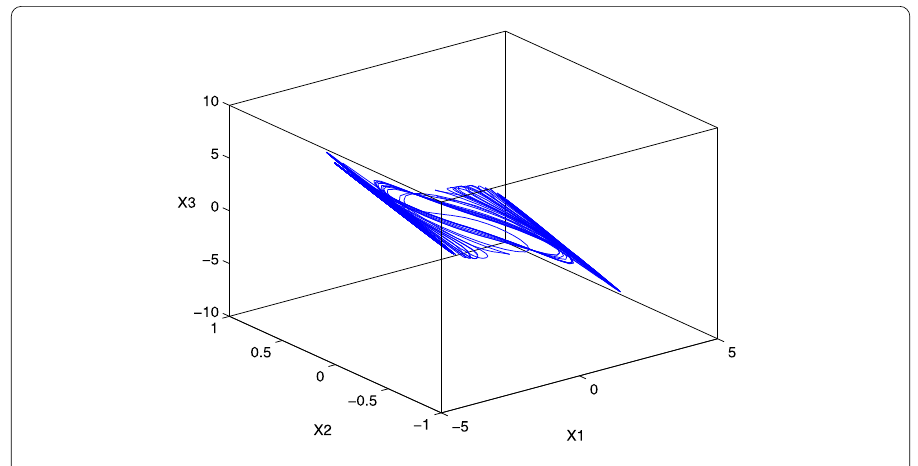
Figure 4 The chaotic state of the third